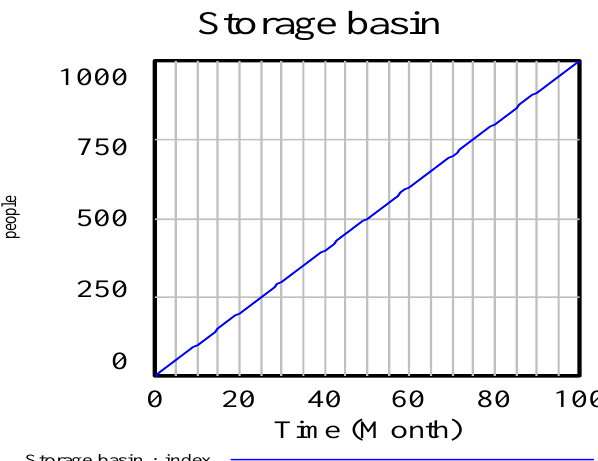
Figure 4: Population and storage basin dynamics variation Using the sustainability index (SI) defined in Equation 6, the medium and long-term water fulfillment from both sides (supply and demand) at varied dependability flow conditions was as depicted in Table 2.